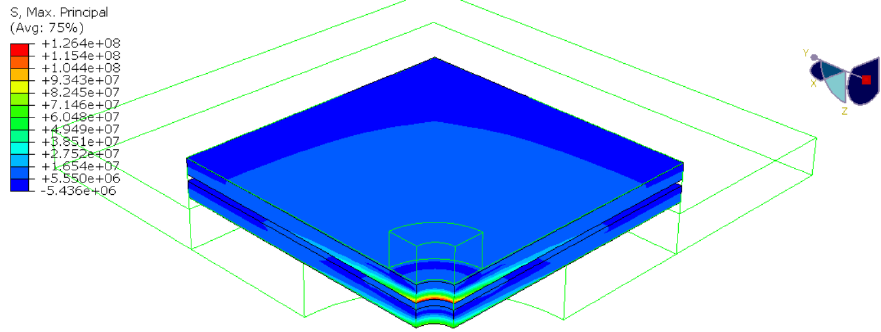
Figure 13. Results of the numerical study for test series G8: maximum principal (tensile) stress in glass at failure (values in Pa).